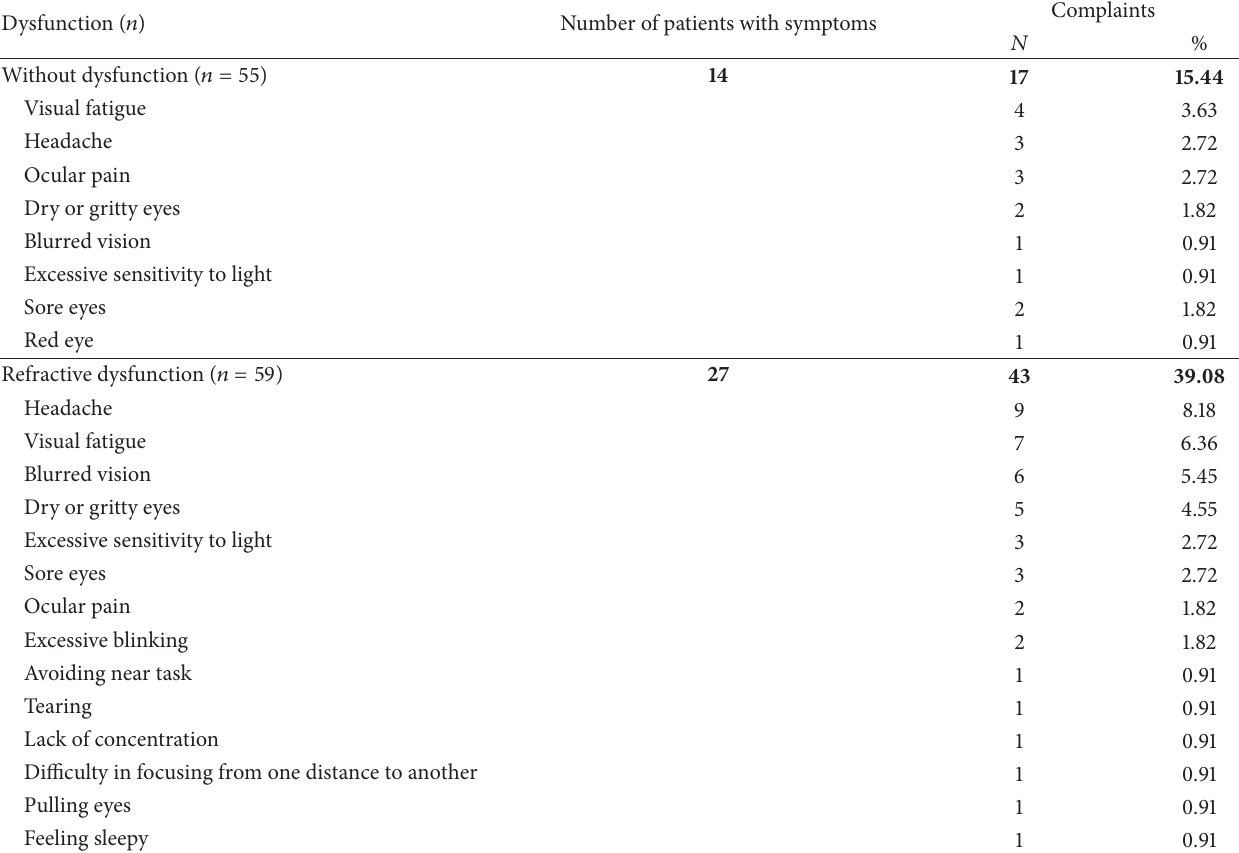
Table 3: Symptoms related to subjects with refractive dysfunction and without